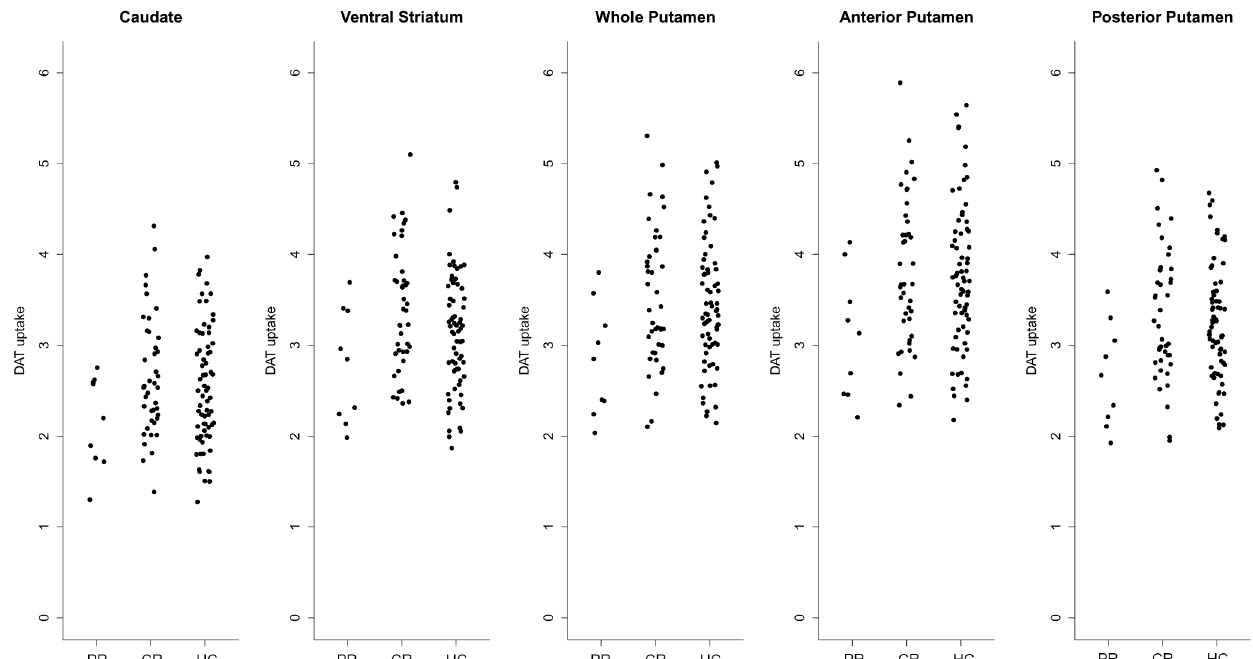
Fig 1. The 18 F-FP-CIT uptake in the striatal subregions of partially (PR) and completely recovered (CR) patients and healthy controls (HC).